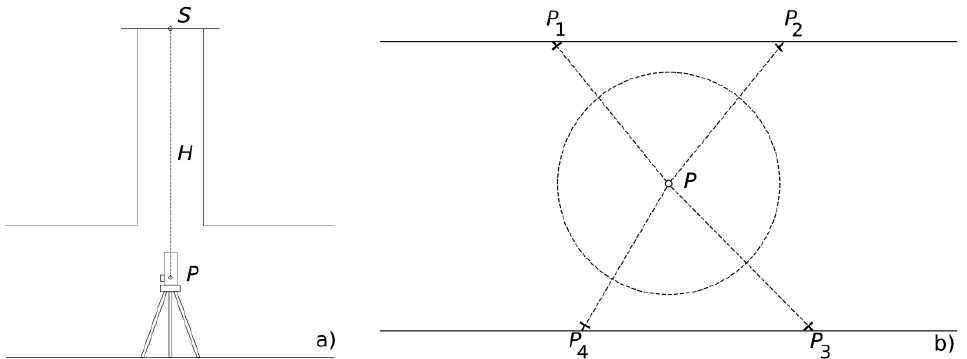
Figure 5. Network connection via a vertical shaft. ( a ) Vertical projection, ( b ) horizontal